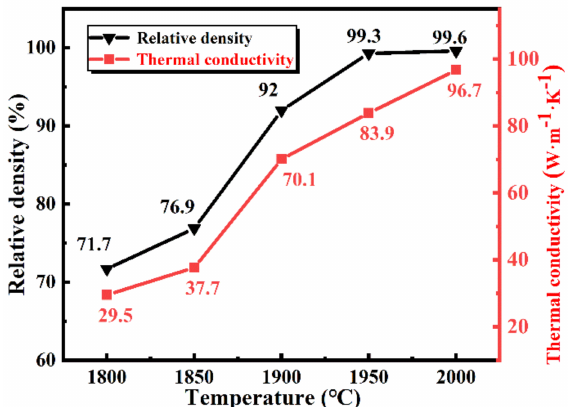
Figure 5. Relative density and thermal conductivity of the sintered SiC samples with 9 wt.% Y 2 O 3 -Er 2 O 3 as a function of sintering